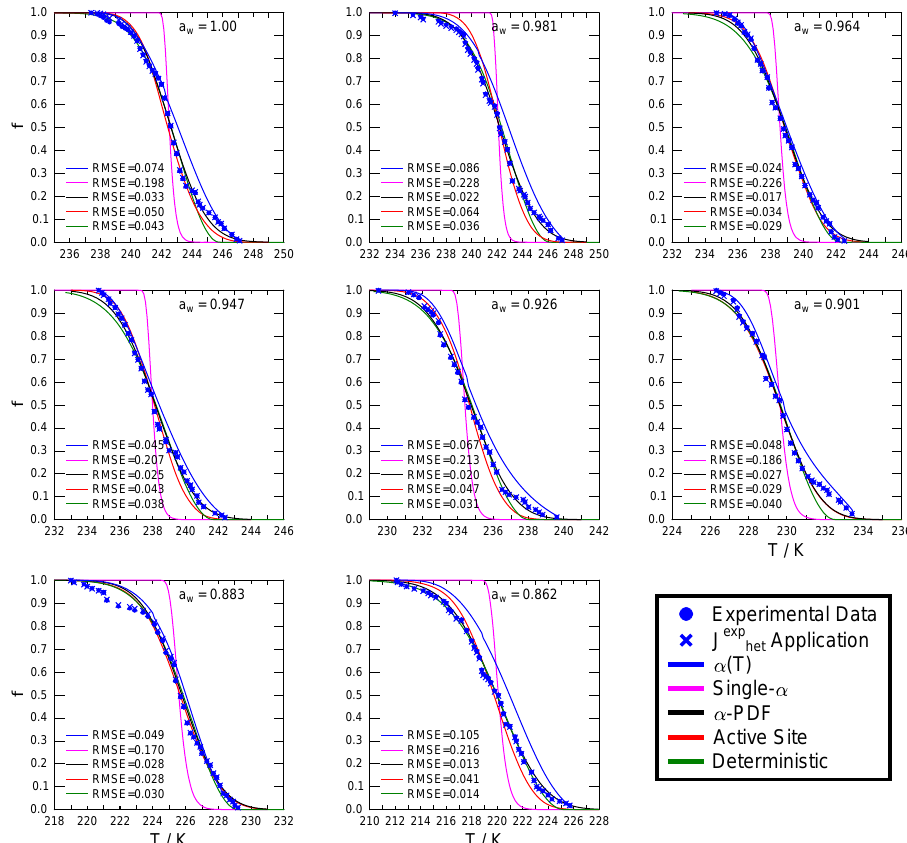
Fig. 5. Summary of different immersion freezing descriptions for water and aqueous ( NH 4 ) 2 SO 4 droplets containing Pahokee peat as a function of T and a w . The experimentally derived cumulative frozen fraction, f , of droplets in 0.2K temperature increments is represented by blue circles. Blue crosses indicate application of experimentally derived heterogeneous ice nucleation rate coefficient, J exp f . Blue, magenta, black, red, and green lines represent α(T ) , single- α , α -PDF, active sites, and deterministic model, respectively. The fit quality is given by the